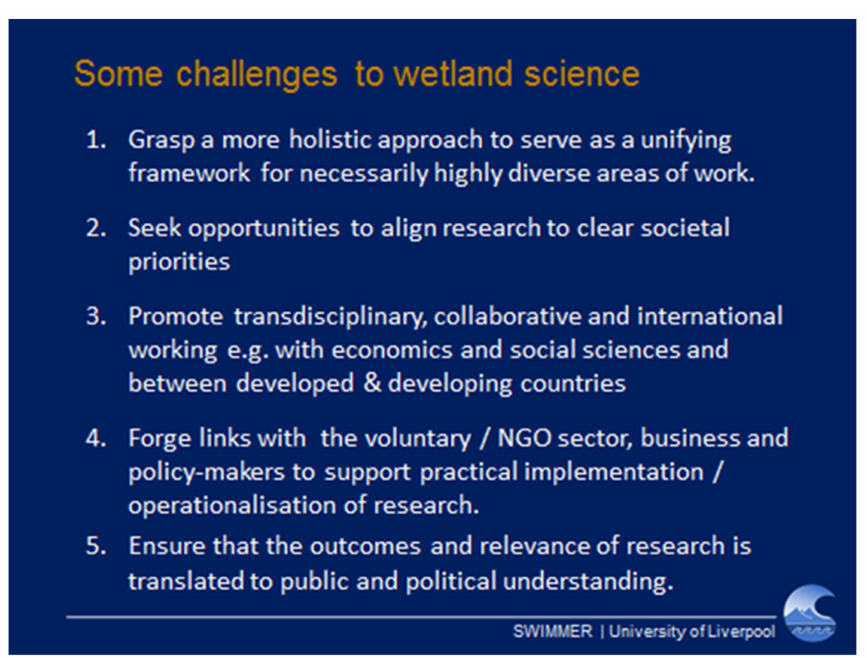
Figure 33. Some Key Challenges for wetland science. Source: Edward